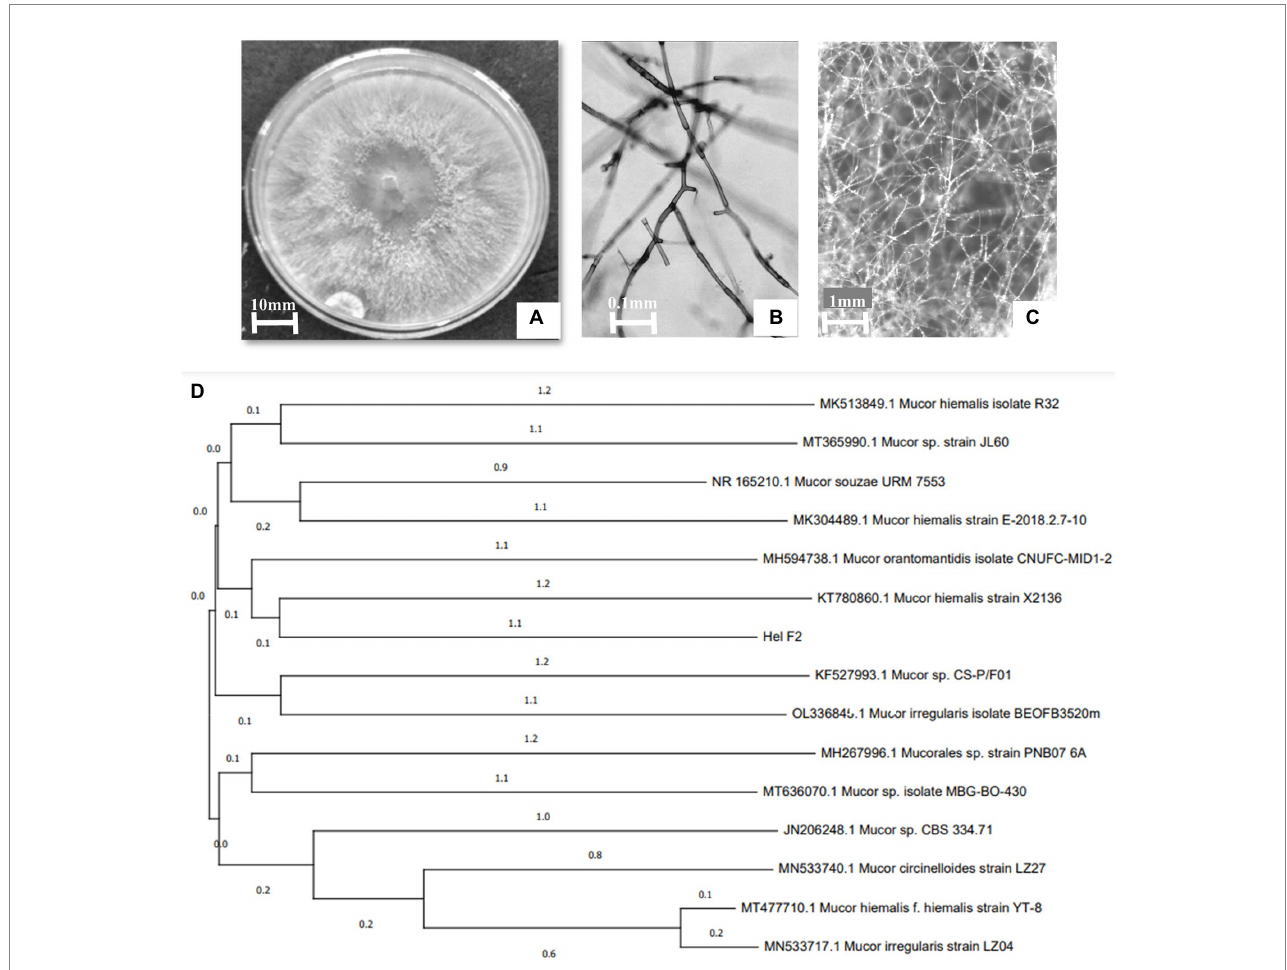
x 2 3 –0.85426 x 2 4 . Here Y GRH is the predicted GRH yield and x 1 , x 2 , x 3, and x 4 are the four coded factors of glucose concentration, peptone concentration, medium pH, and fermentation time (day) respectively. A regression analysis with detailed statistical data related to the experiment is presented in Table 4. The F-test data of 1994.082 proved that the model was significant. The adjusted determinant coefficient (R 2 Adj) was found to be 0.9998 which represents that there is a high degree of correlation between the experimental and predicted values and there is more than 99% variation in response that could be predicted by second-order polynomial prediction equation. Adeq precision was reported to be 111.901 which indicates that the model is appropriate. The lack of fit F -value of 5.782 and p -value ( p < 0.0001) was not at all valuable